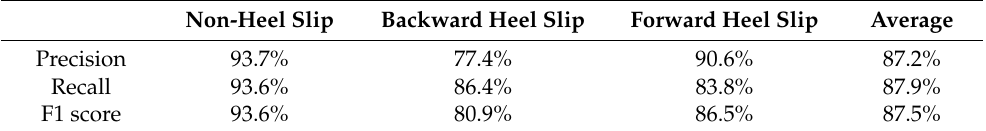
Table 6. Heel slip classifier